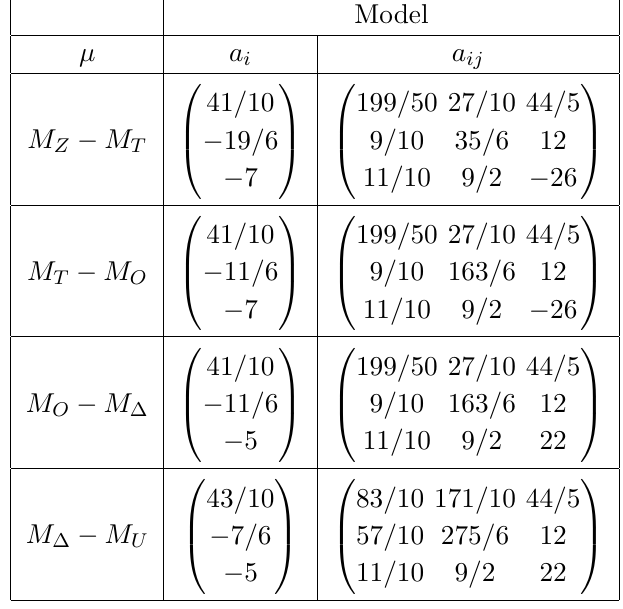
Table 3 . One-loop and two-loop beta function coe(cid:14)cients in the respective ranges of mass